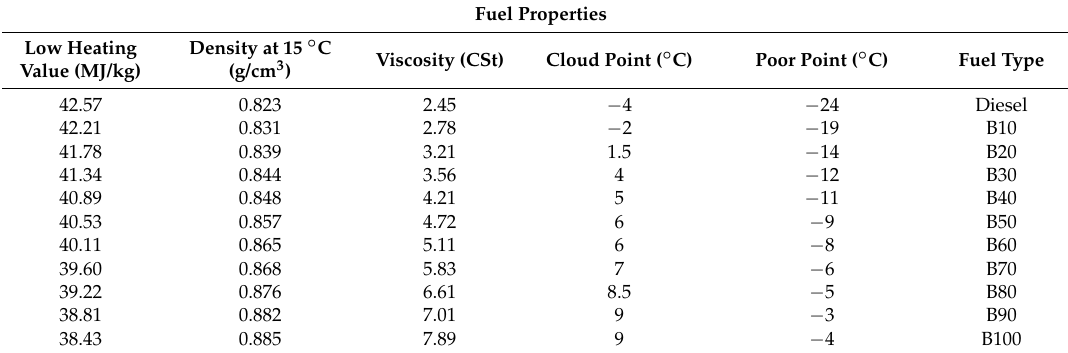
Table 1. Biodiesel and diesel fuel blend